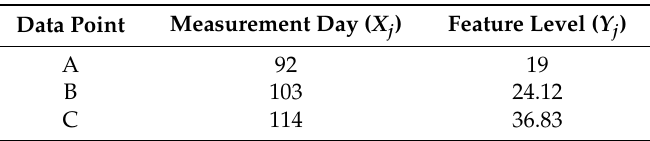
Figure 4. Kurtosis extracted from the original vibration signal. The well-known kurtosis value for normal bearing is 3 [40]. The alarm threshold is set at 4 × 3 = 12. Table 2. Non-linear data points.